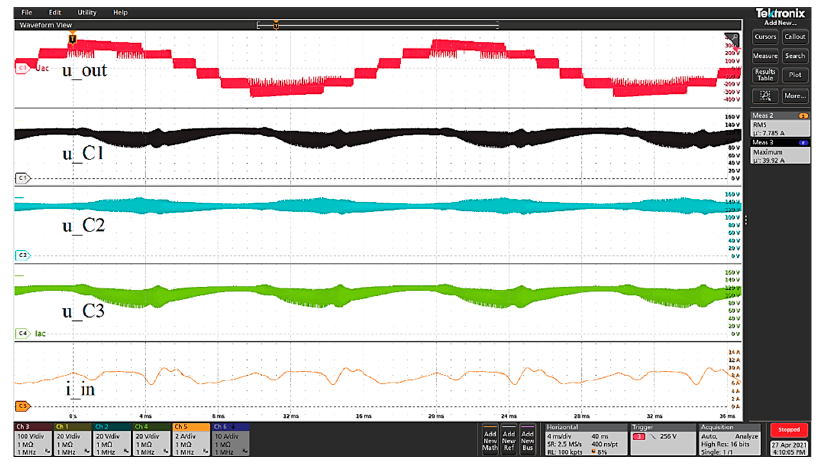
Figure 25. Operation of the AIVB with variable switching frequency. Waveforms of the output voltage of the inverter ( u out [100 V/div]), voltage on the DC-link capacitors ( u C1 , u C2 , u C3 [100 V/div]) and the current of the DC-power supply connected with the C 2 capacitor ( i in [2 A/div]).